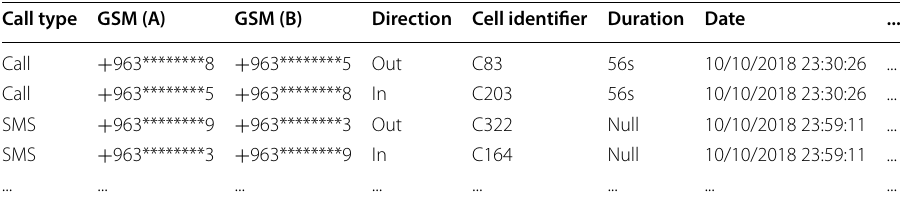
Table 1 CDR sample fields